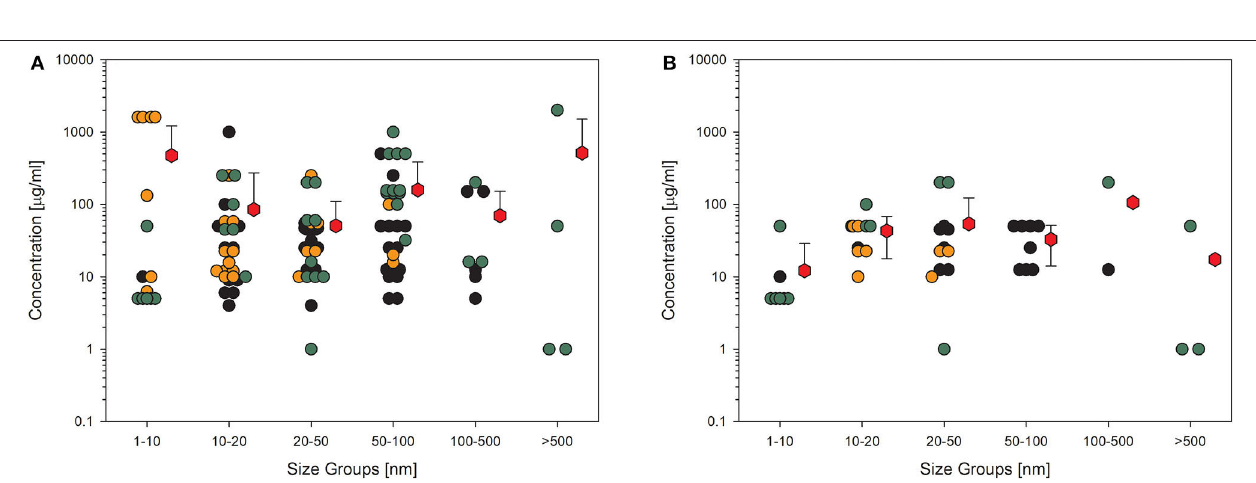
FIGURE 4 | Results of the evaluation of in vitro studies on induction of ROS production in cells treated with amorphous silica. Data have been collected in six size groups for primary particle size as indicated on the abscissa. (A) All available datasets; (B) datasets from studies with high-quality scores of 0.8 or 1. Details are as those shown in Figure 2 . Data points taken from the references are given in the Supplementary Material .